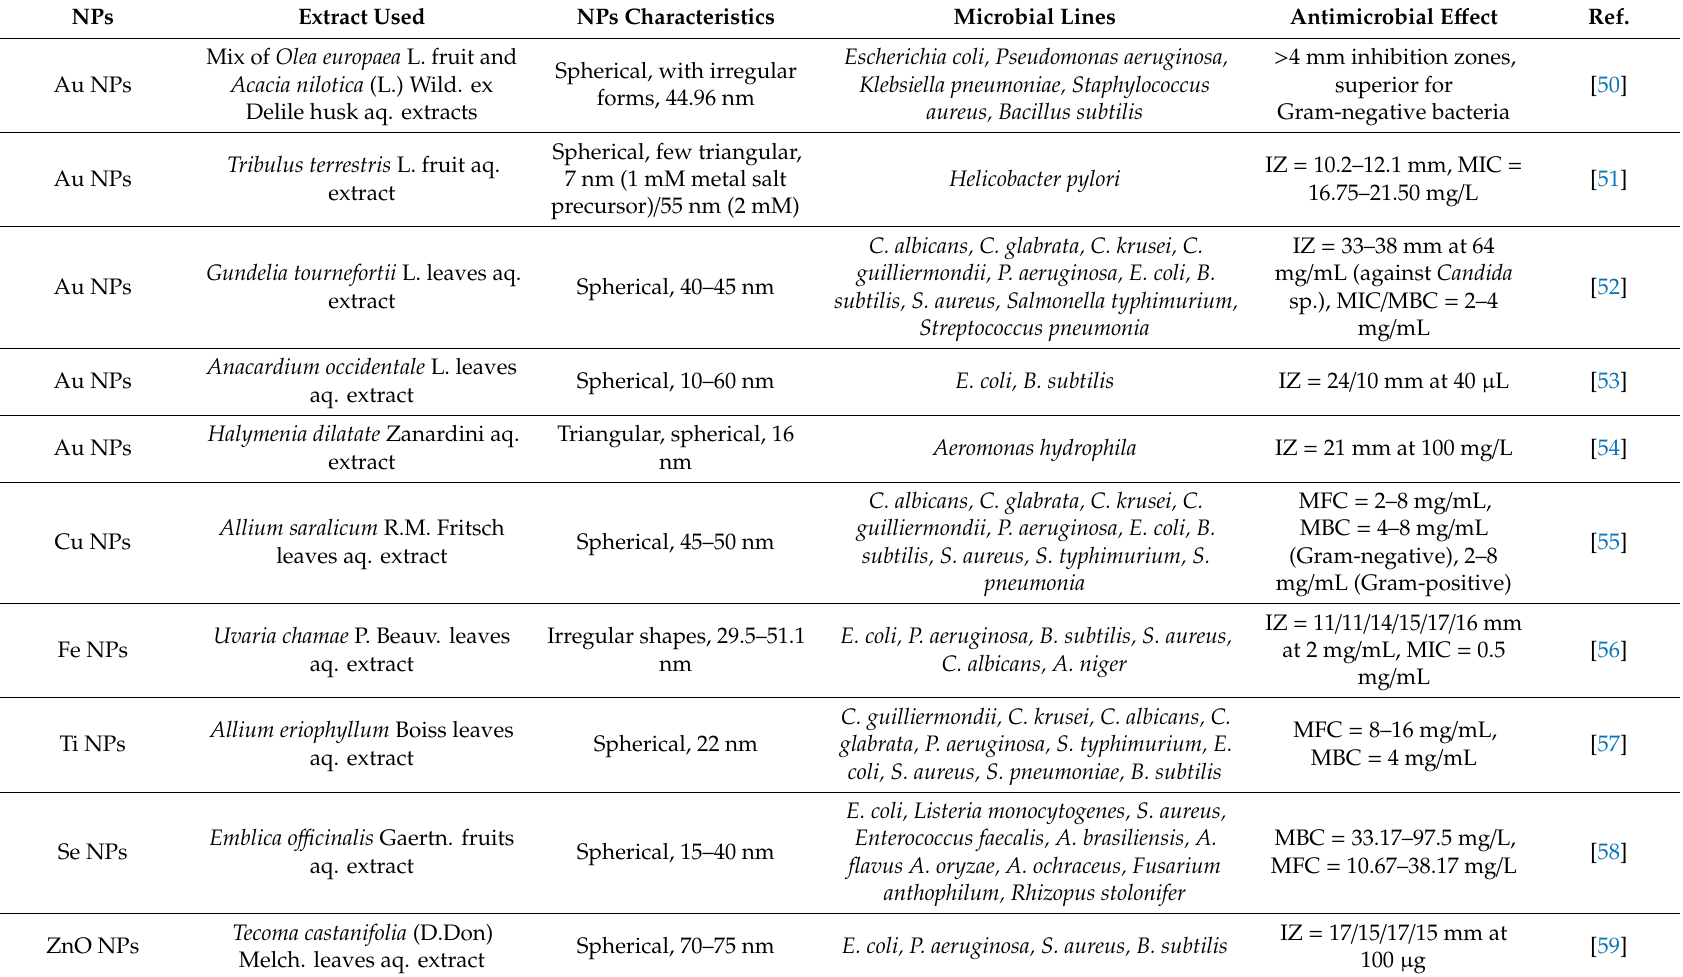
Table 2. Antimicrobial potential of other phytosynthesized nanoparticles (as presented in studies published in